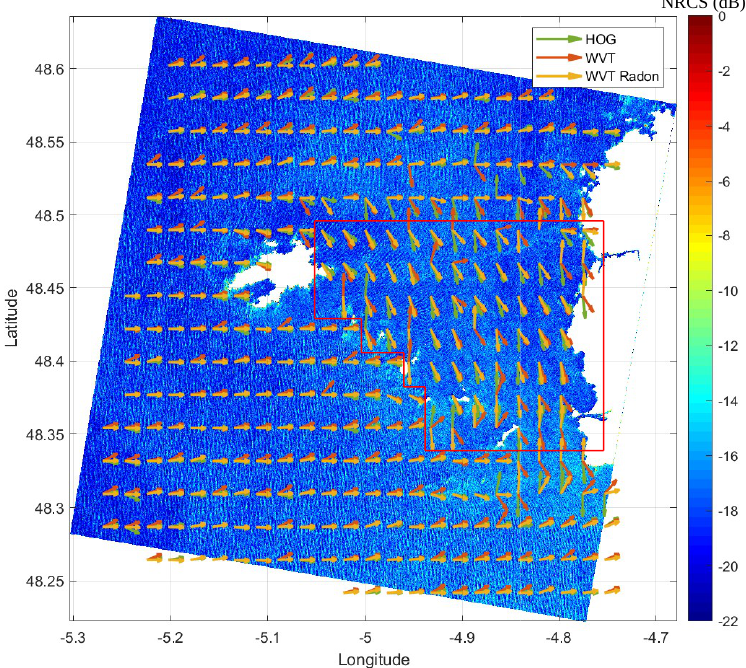
Figure 13. RADARSAT-2 SAR image taken on 29 December